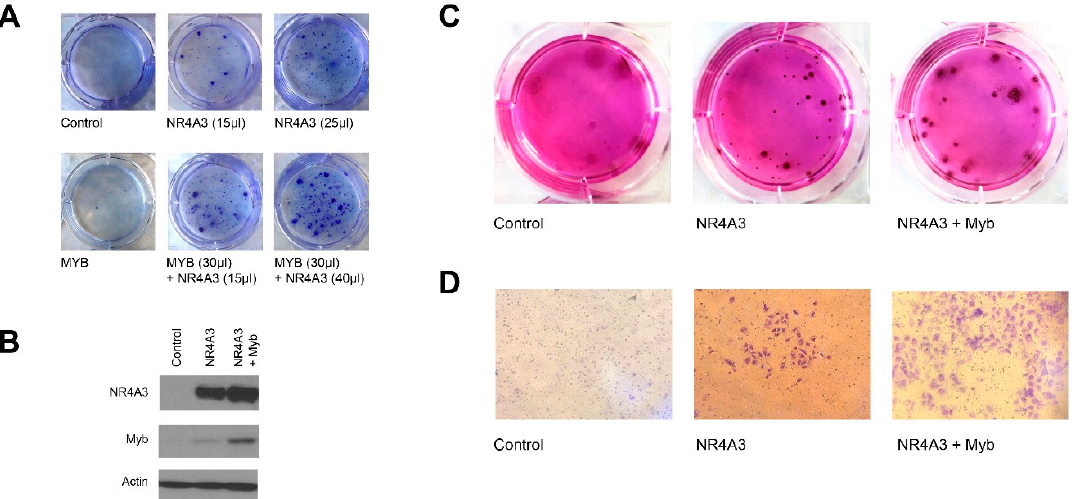
Figure 6. NR4A3 and MYB overexpression induce transformation of RK3E epithelial cells. ( A ) Rat kidney epithelial cells (RK3E) immortalized with E1A adenovirus were transduced with lentivirus containing empty vector (EV), NR4A3, Myb or the combination as indicated. For the NR4A3 plus Myb combination, RK3E cells were initially transduced with NR4A3 for 3 weeks. Then, Myb virus was added for 10 days. At day 31, cells were fixed, and images were captured; ( B ) NR4A3 and Myb protein expression. Transformed clones were isolated, and cell extracts were subjected to immunoblot with the indicated antibodies; ( C ) anchorage-independent growth assay. Transformed colonies from RK3E assay were isolated and seeded at 100–300 cells per well in media containing methylcellulose and grown for 11 days; ( D ) Boyden chamber assay. Transformed colonies were seeded in the 6 well Matrigel invasion chamber with 8-micron pores. Invasive cells were fixed and stained after 22 h.